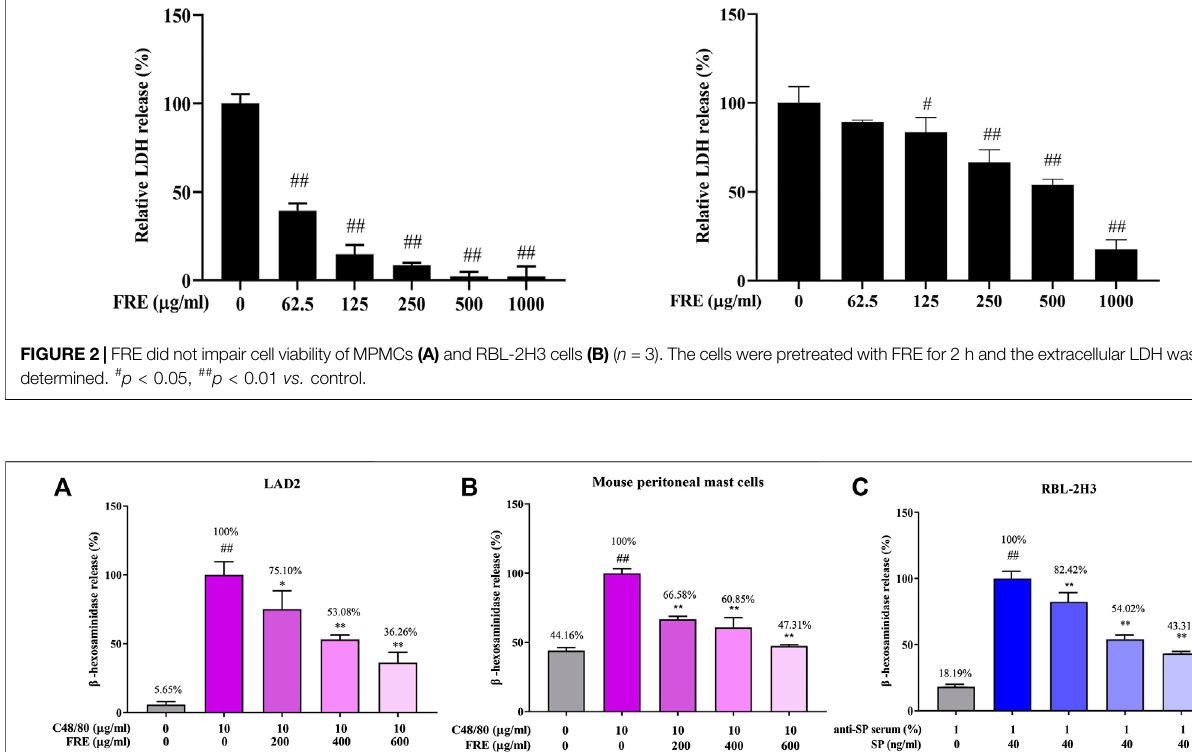
Frontiers in Pharmacology |